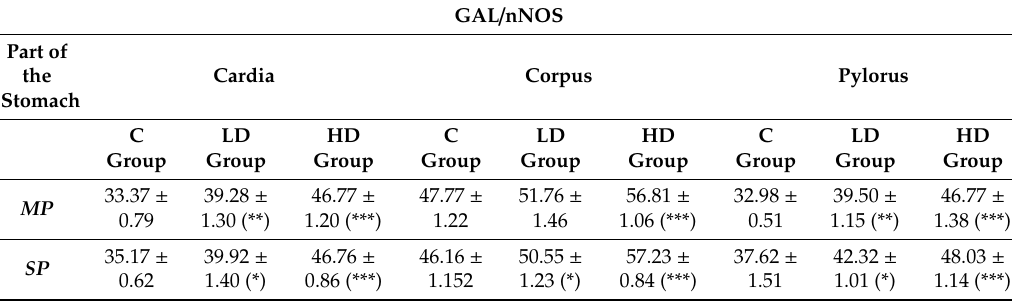
Table 3. Co-localization of GAL with nitric oxide synthase (nNOS) in the enteric neurons in various parts of the porcine stomach under physiological conditions (C group) and after low dose (LD group) or high dose (HD group) of acrylamide